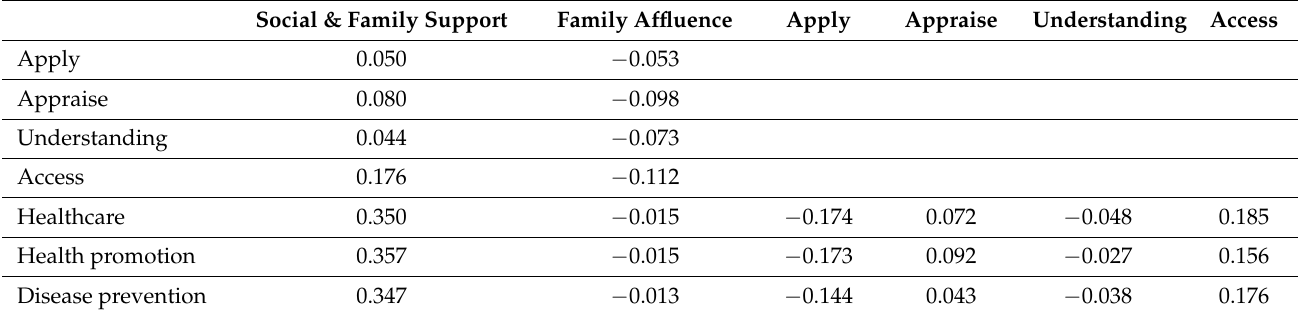
Table 1. Standardized Total